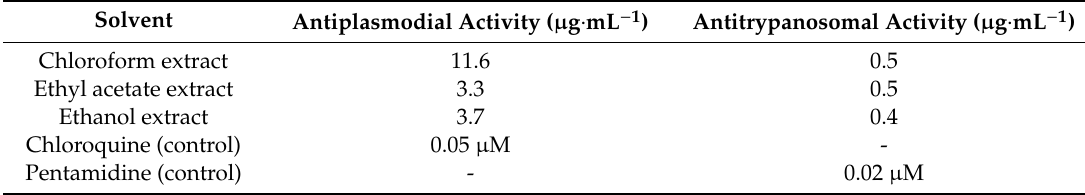
Figure 2. Antiplasmodial activity of chloroform, ethyl acetate and ethanol extracts of O. genistifolia ( a ), dose-dependent curves of the antiplasmodial activity of chloroform (14), ethyl acetate (15) and ethanol (16) extracts of O. genistifolia ( b ). Table 2. Antiplasmodial and antitrypanosomal activities of chloroform, ethyl acetate and ethanol extracts of O. genistifolia against P. falciparum strain 3D7 and Trypanosoma brucei brucei .